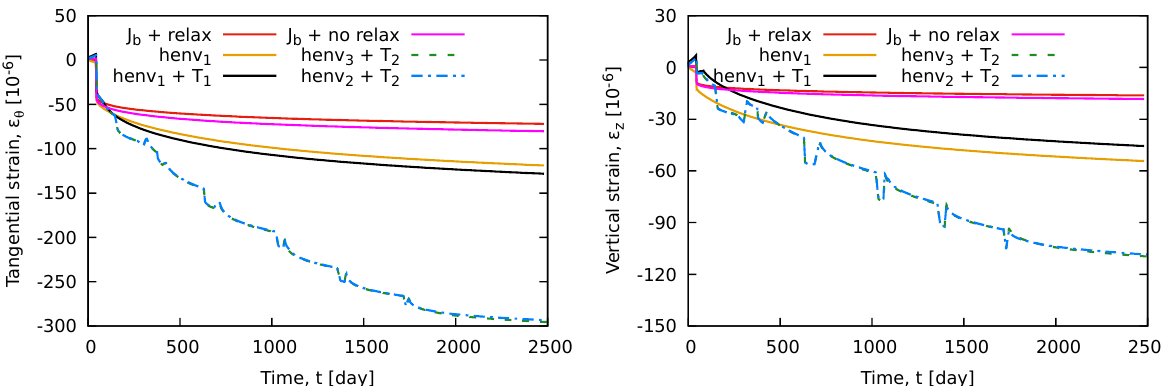
Figure 3. Evolution of hoop (left) and vertical (right) strain in the center of the wall computed for different histories of ambient conditions, with basic creep only and with no steel relaxation.